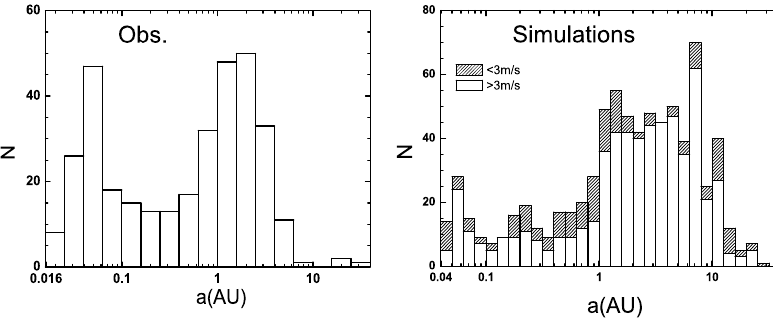
Figure 3. Comparing observations and our simulations in statics about the semi-majoy